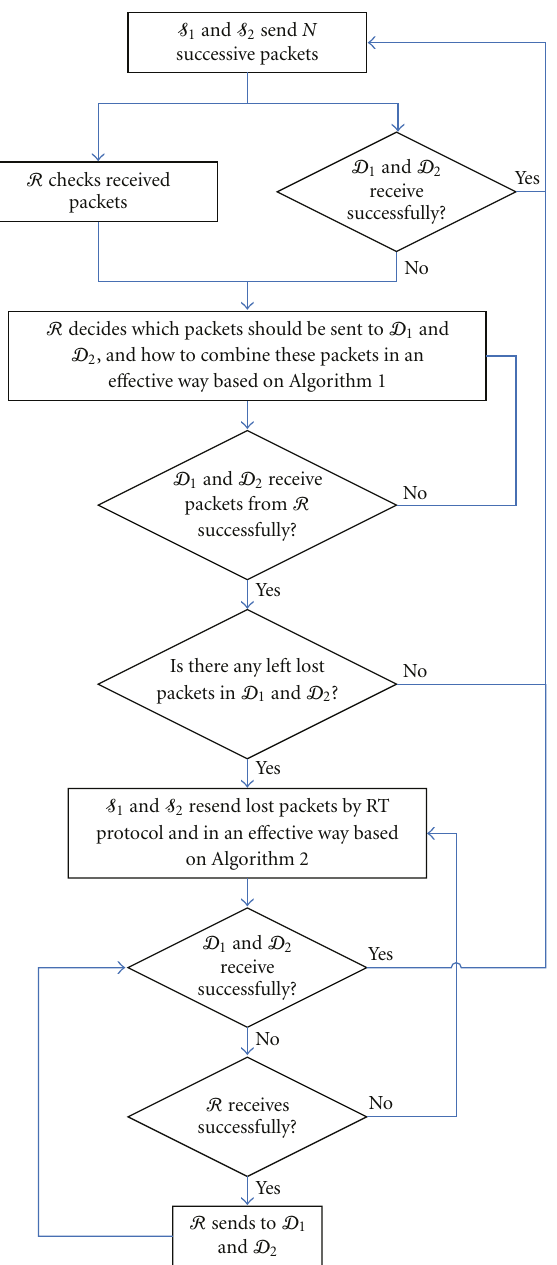
Figure 3: Block diagram of proposed